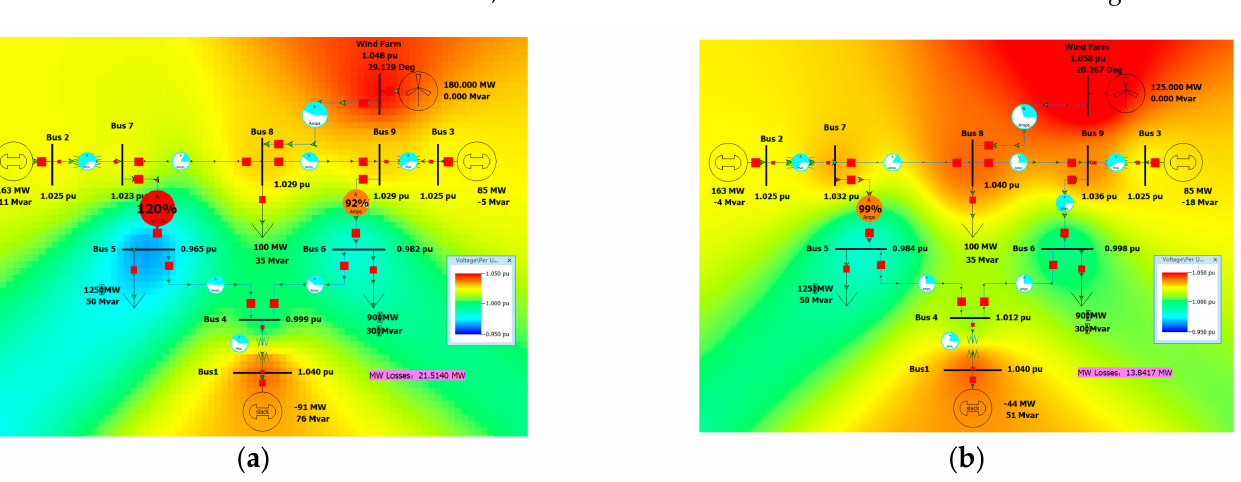
Figure 10. Simulation results of the minimum load of tower A connected to bus No. 8 (150 km). ( a ) The results under the minimum load condition and ( b ) minimum load condition with reducing Wind Farm